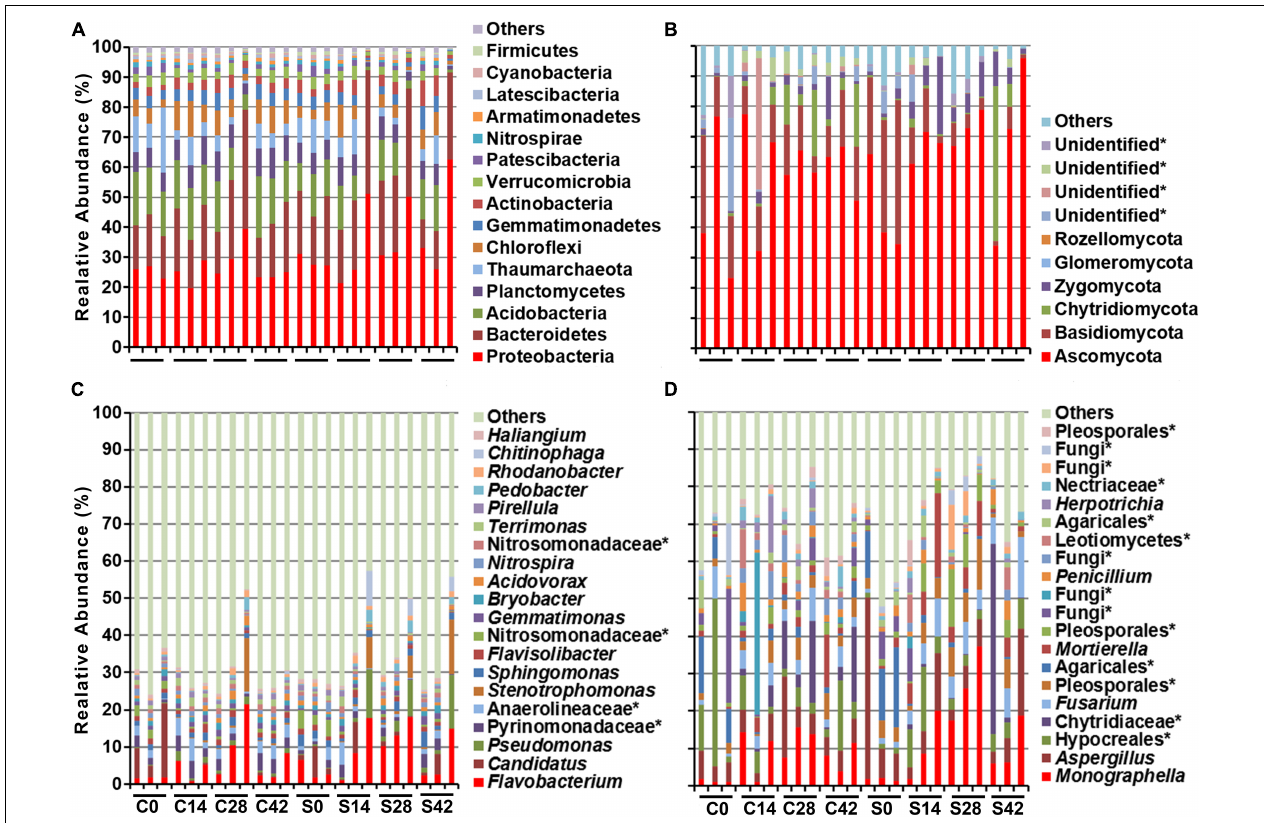
FIGURE 2 | Effect of S. alfalfae XY25 T on microbial community. Bacteria at (A) phylum and (C) genus level and fungal at (B) phylum and (D) genus level. C0, C14, C28, and C42 represent the sampling days 0, 14, 28, and 42 in the control group, respectively; S0, S14, S28, and S42 represent the sampling days of the treatment